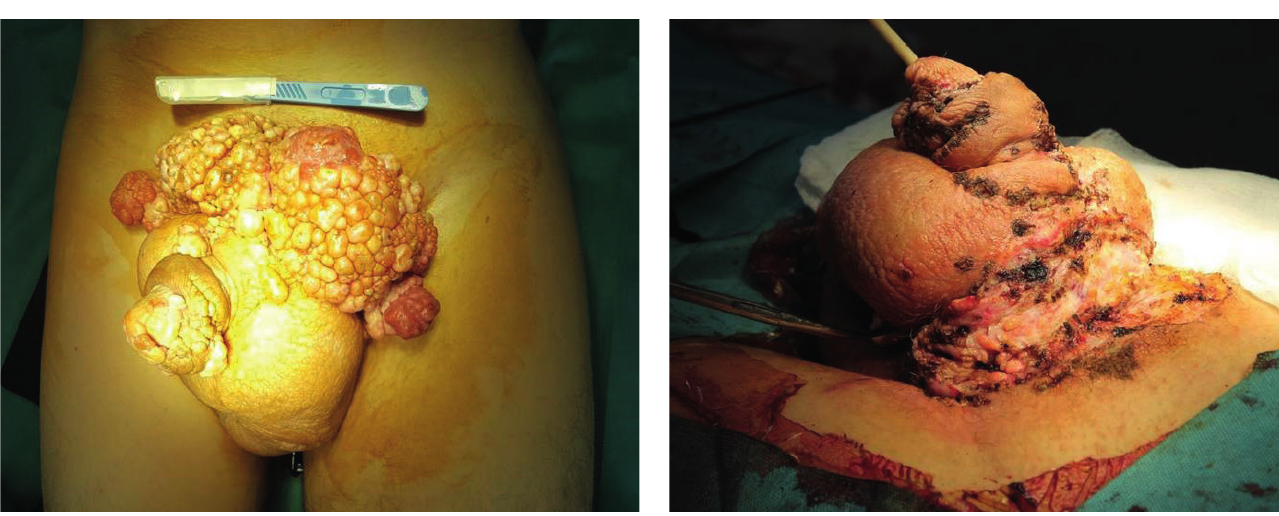
Figure 1 - Giant tumor seen involving the glans penis, shaft of the penis, groin and pubic region of anterior abdominal wall. Despite the extensive nature of the disease, there was no malignant transformation. Note the left hemi lymphedema.